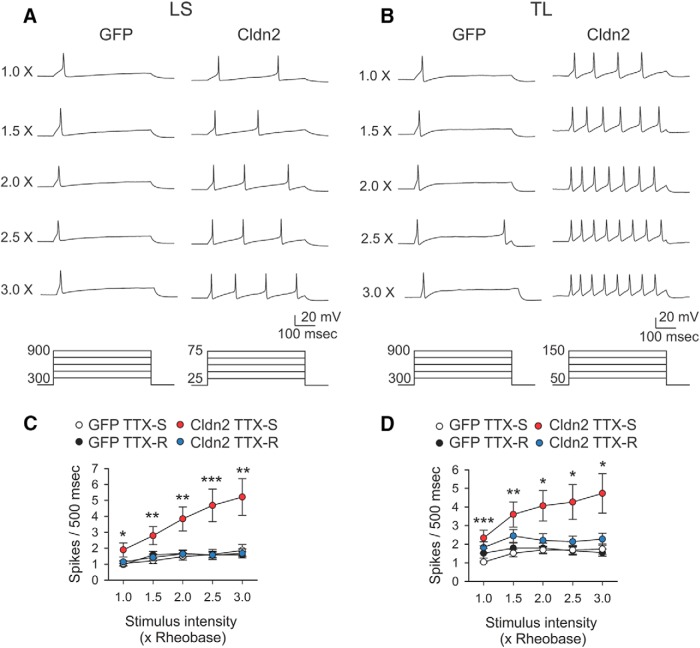
Overexpression of Cldn2 in the urothelium sensitizes LS and TL bladder sensory neurons with TTX-S action potentials. LS (L6-S2) and TL (T13-L2) DRGs were harvested from rats transduced with AdGFP or AdCldn2. The response of sensory neurons to suprathreshold stimulation was examined with the perforated patch-clamp technique. A, B, Representative tracings of action potential firing pattern in response to suprathreshold stimulation for LS (A) and TL (B) bladder DRG neurons with TTX-S action potentials. Action potentials were evoked by the injection of 500-ms depolarizing current pulses [1, 1.5, 2, 2.5, and 3 times (X) the rheobase] through the patch pipette. Current pulse protocols are shown at the bottom of the panels. C, D, Stimulus response relationships for LS (C) and TL (D) bladder sensory neurons. Action potentials were evoked by the injection of depolarizing current pulses as indicated above. The number of spikes evoked in response to stimuli of increased intensity for each neuron were computed. Sensory neurons were classified on the basis of their origin and the sensitivity of the action potential to 1 μM TTX. Statistically significant differences between neurons with TTX-S action potentials from rats transduced with AdCldn2 and control TTX-S counterparts are indicated as, *p < 0.05, **p < 0.01, and ***p < 0.001 (n = 15–36, Mann-Whitney nonparametric test).